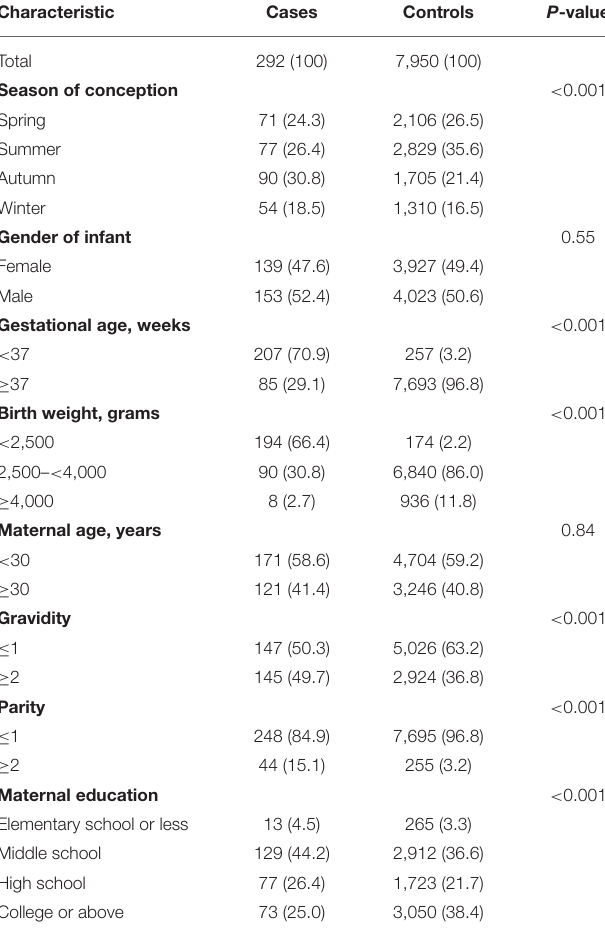
TABLE 2 | Ambient SO 2 levels ( µ g/m 3 ) and the number of air monitoring stations in 14 cities in Liaoning Province, China, between 2010 and